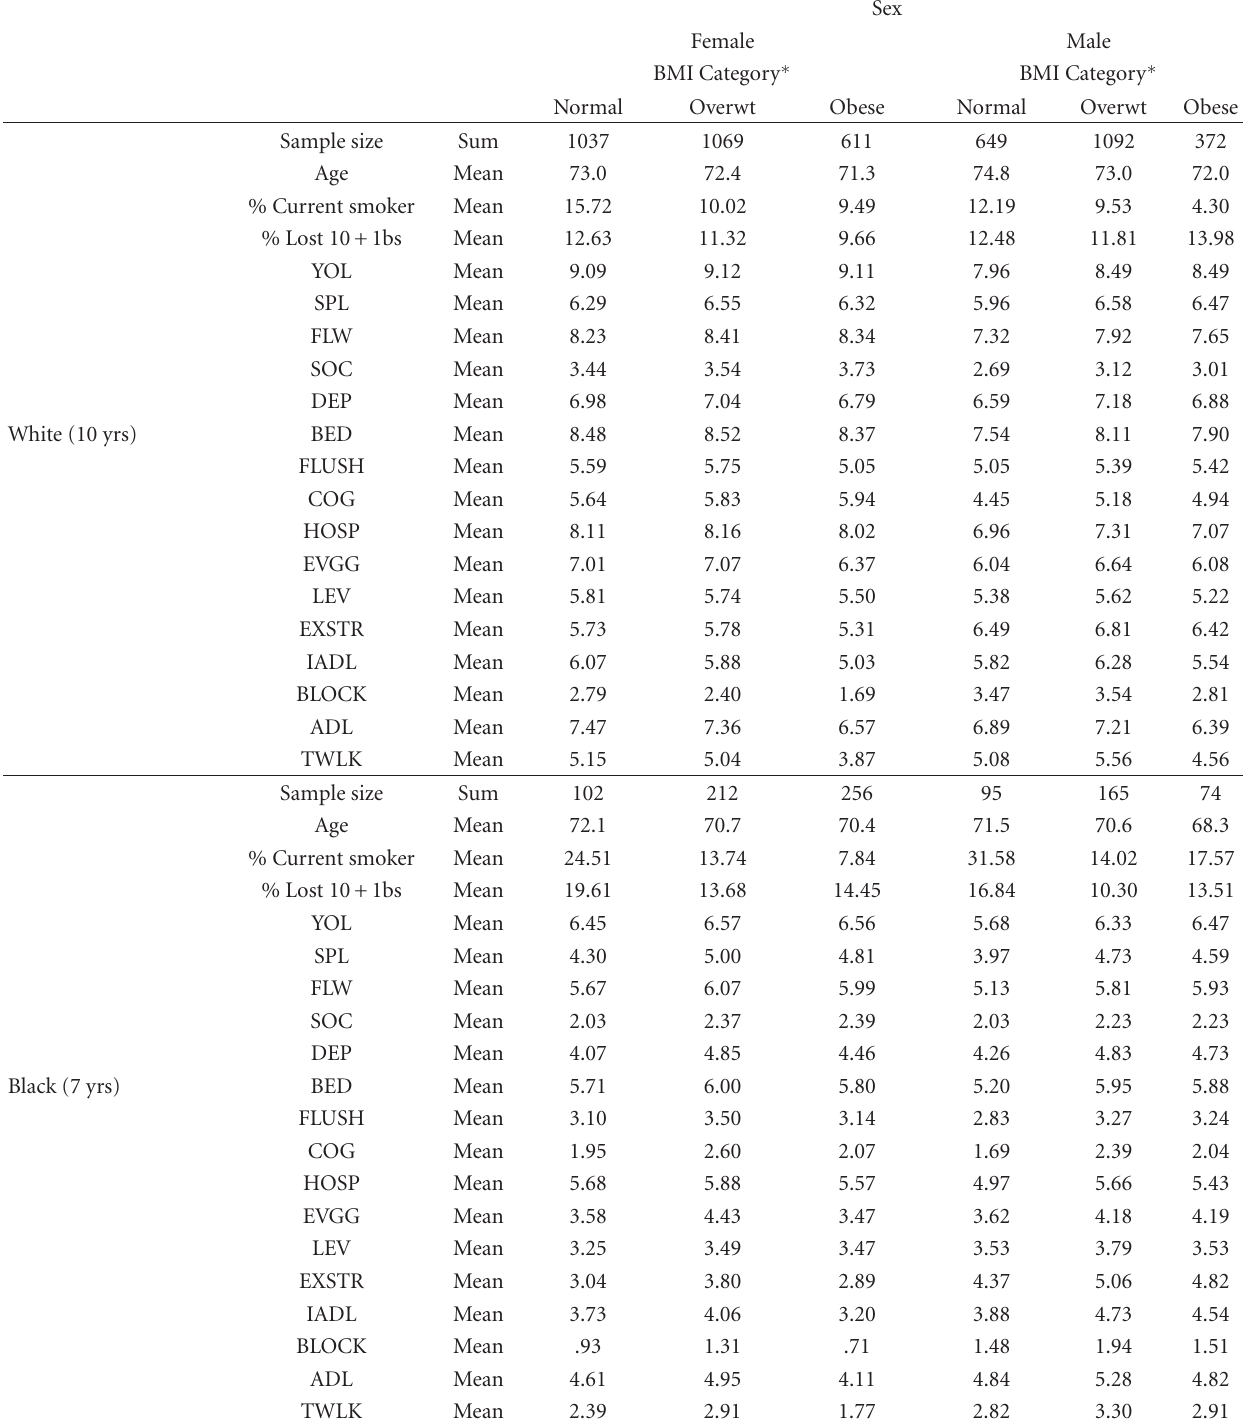
Table 5: Means by BMI ∗ , gender, and